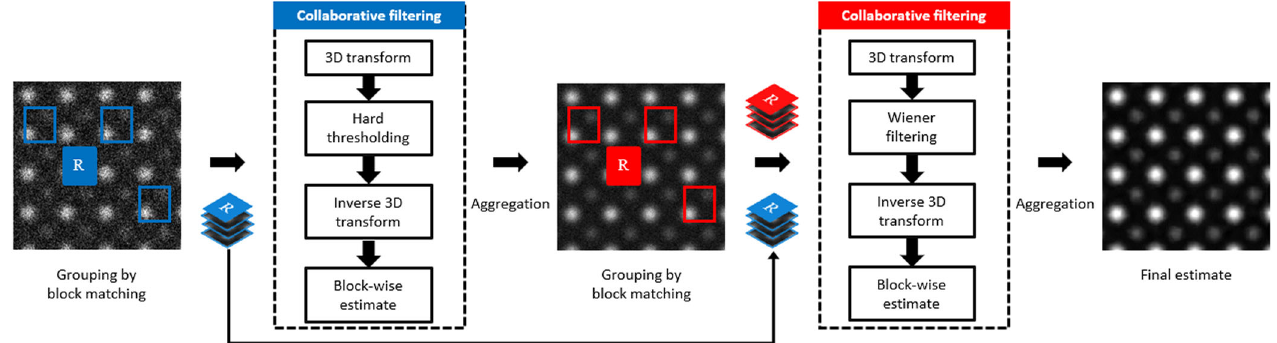
Fig. 2 Illustration of how block matching and 3D fi ltering removes noise in STEM images. Group-wise block matching is performed to reduce noise in the STEM images. Block-matching 3D fi ltering consists of two steps. Using block matching, noise blocks are stacked in a 3D form and denoised by hard thresholding. Subsequently, another block matching and Wiener fi ltering are performed using the denoised block as a ground